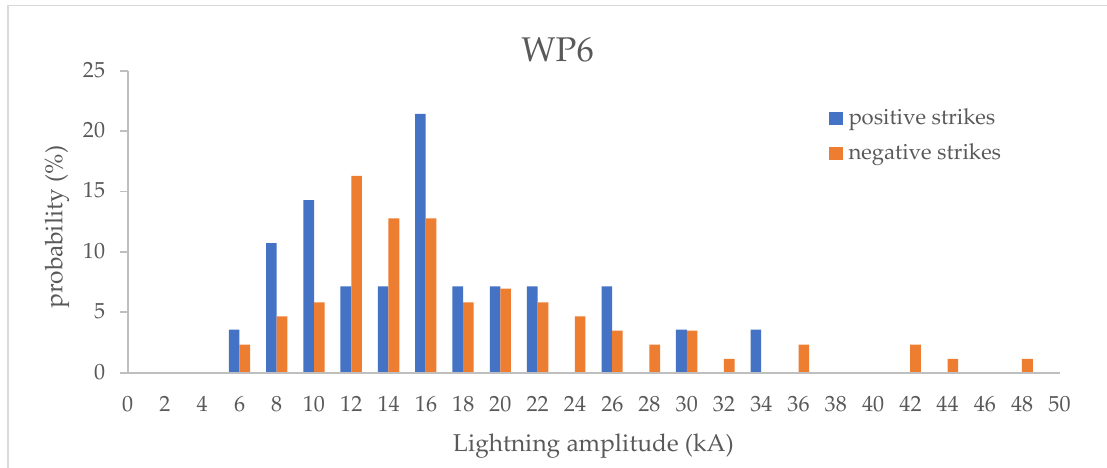
Figure A6. Lightning current amplitude probability distributions for positive and negative strikes extracted from the recorded incidents throughout the period 2011–2020 for WP6.